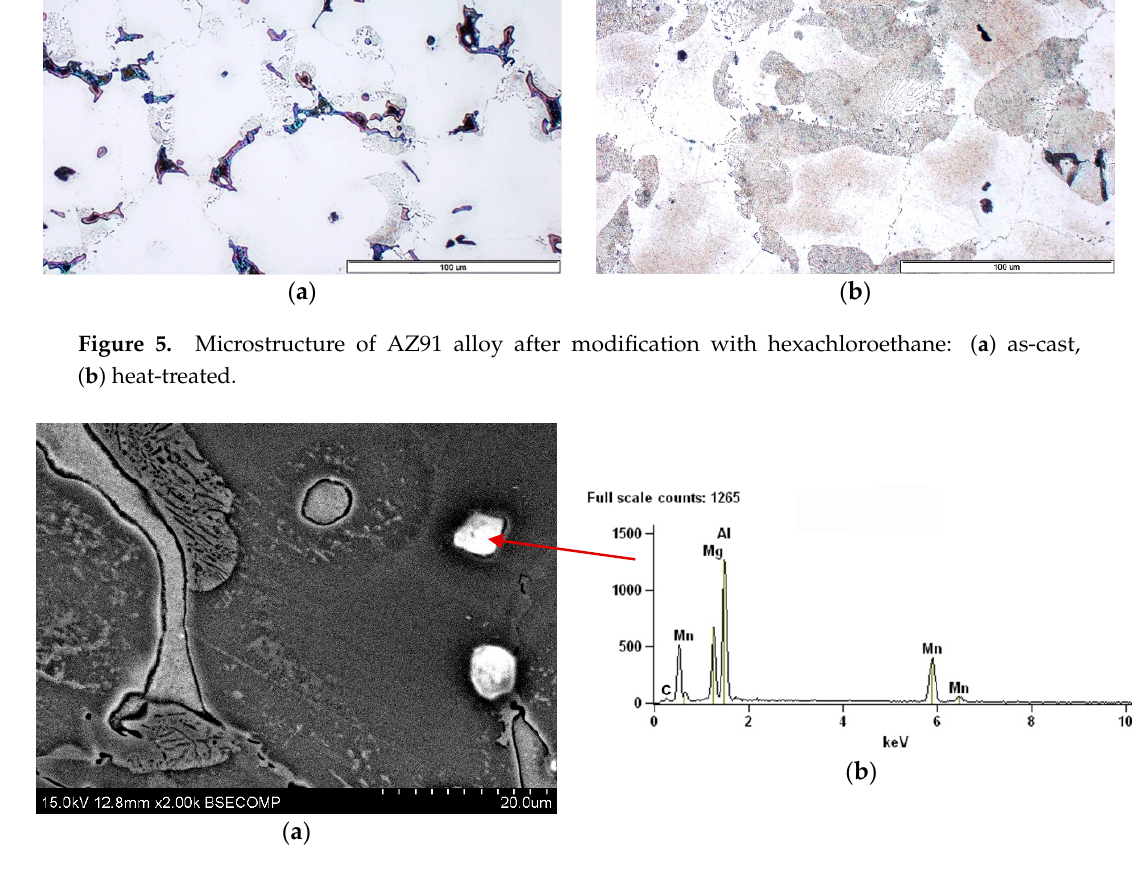
Figure 5. Microstructure of AZ91 alloy after modification with hexachloroethane: ( a ) as-cast, ( b ) heat-treated.